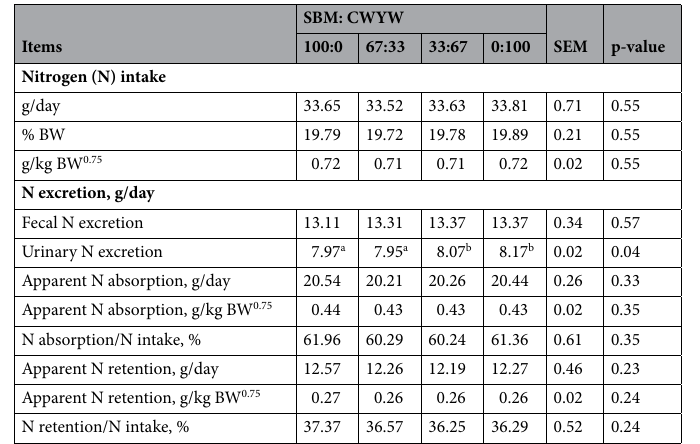
Table 6. Effect of replacing soybean meal with citric waste fermented yeast waste on nitrogen utilization and efficiency in Thai-native cattle. SEM standard error of the mean, SBM: CWYW replacing soybean meal with citric waste fermented yeast waste ratio. a,b Value on the same row with different superscripts differ (p <